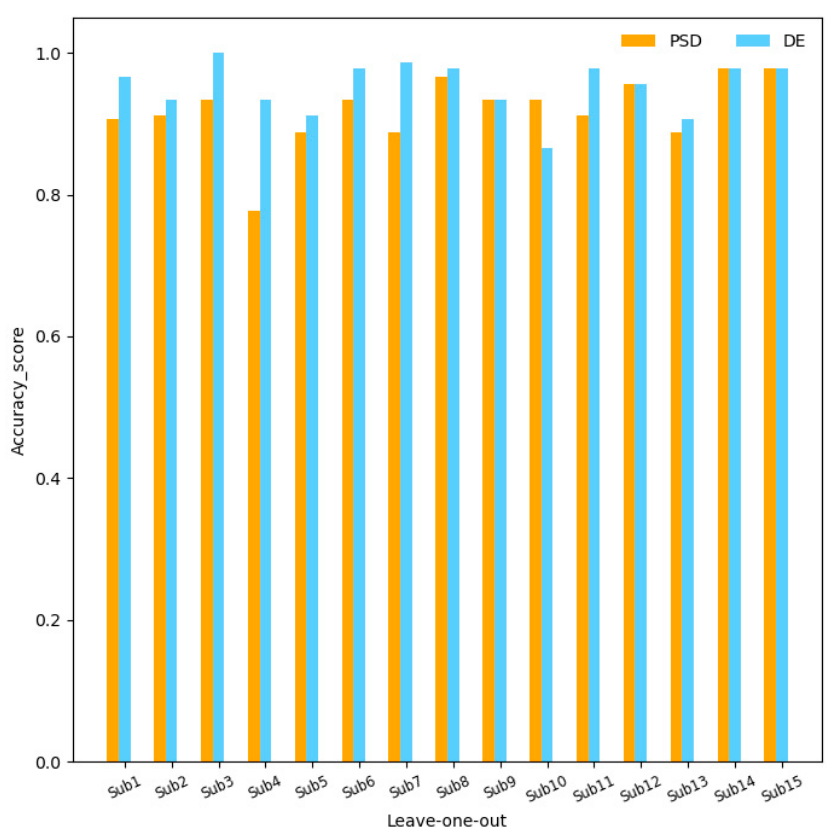
Figure 7. Comparison of PSD and DE characteristics.